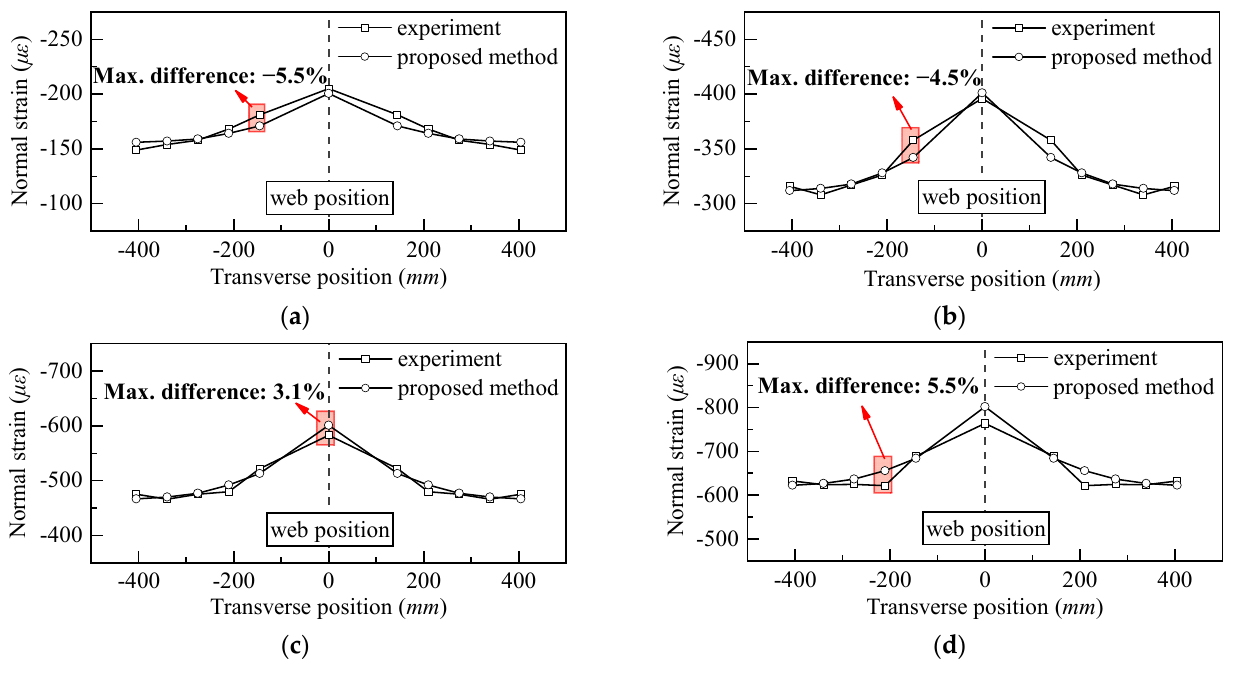
Figure 14. Comparison of the strain in SU-WSCS: ( a ) P = 100 kN; ( b ) P = 200 kN; ( c ) P = 300 kN; ( d ) P = 400 kN.